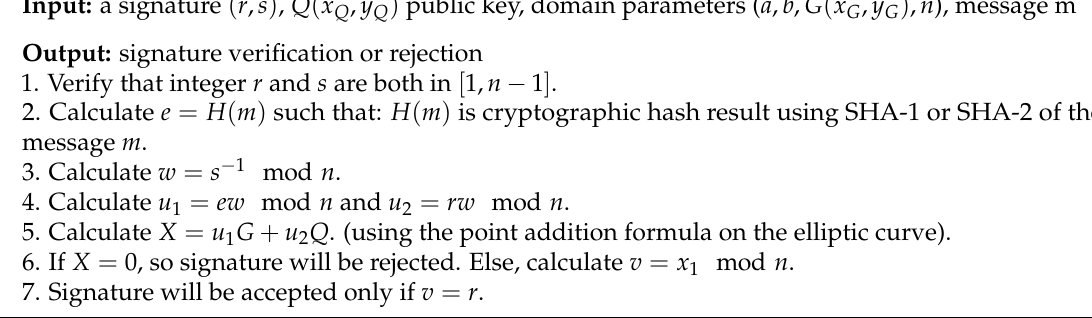
Figure 9 sums up the architecture design of the ECDSA digital signature